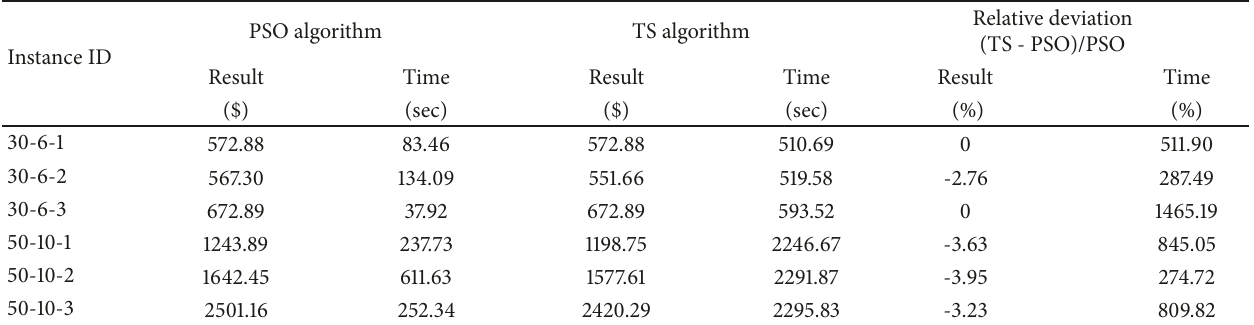
Table 3: Computational results of medium-scale